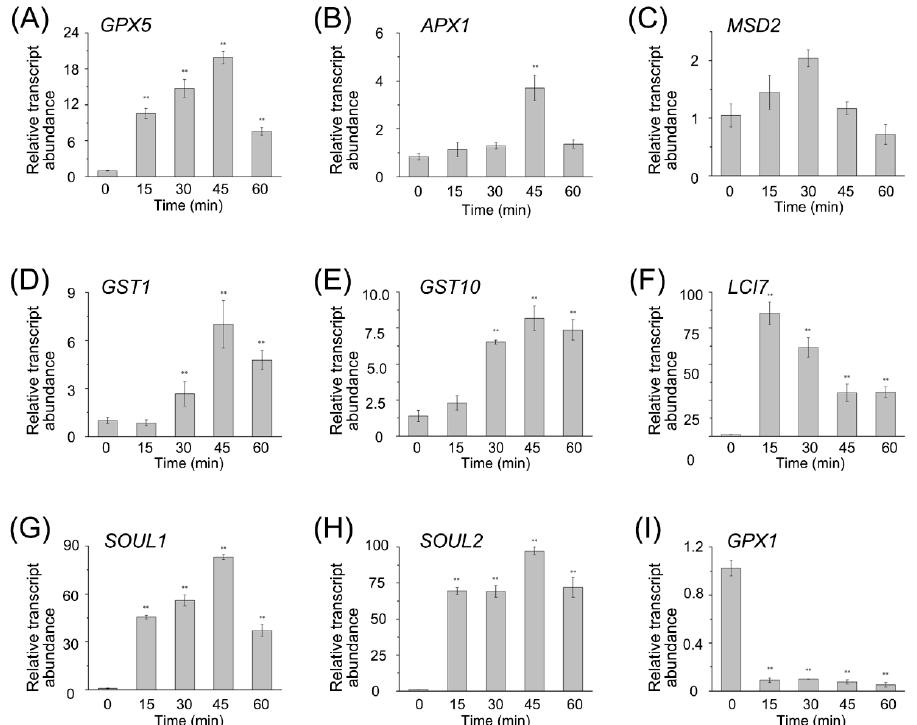
Figure 4. Transcriptional changes of antioxidant-related genes in RB-treated CC4348 cells. The transcript abundance of GPX5 ( A ), APX1 ( B ), MSD2 ( C ), GST1 ( D ), GST10 ( E ), LCI7 ( F ), SOUL1 ( G ), and SOUL2 ( H ) and GPX1 ( I ) at 15, 30, 45, and 60 min after treatment with 1 μM RB in CC4348 were detected,